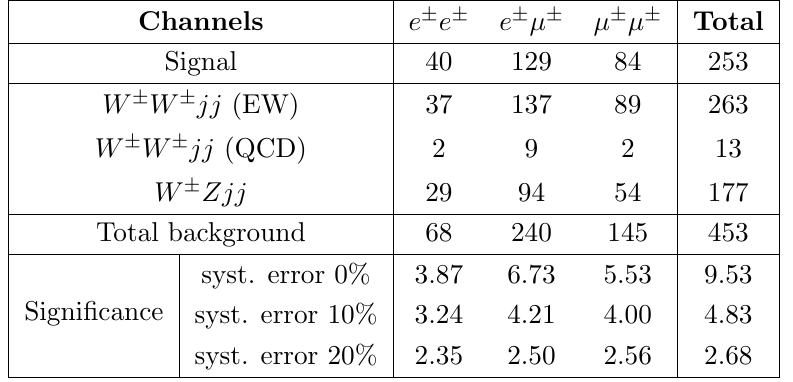
Table 3 . Event yields in di(cid:11)erent lepton (cid:13)avor combination channels e (cid:6) e (cid:6) , e (cid:6) (cid:22) (cid:6) and (cid:22) (cid:6) (cid:22) (cid:6) for both the signal and SM backgrounds at 14 TeV LHC with 3 ab (cid:0) 1 of integrated luminosity. For the signal we set m (cid:30) = 1 GeV and j (cid:21) (cid:11);(cid:12) j = 1 (with (cid:11); (cid:12) = e; (cid:22) ). We consider systematic errors of 0%, 10% and 20% on the background events